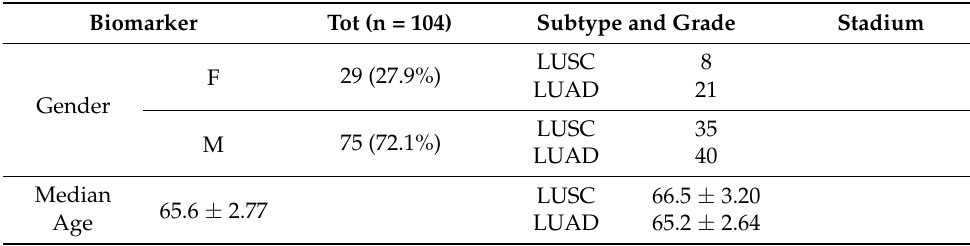
Table 1. Clinicopathological characteristics of the tissue